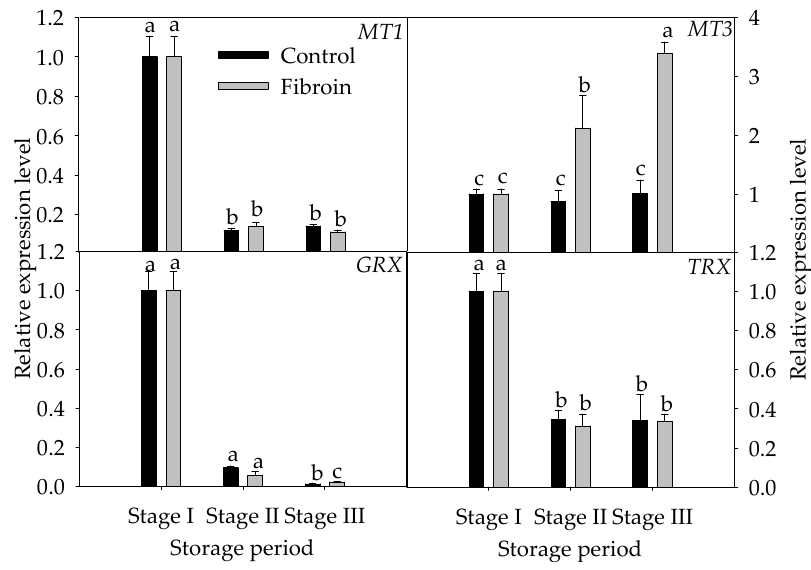
Figure 6. Relative gene expression levels of MT1, MT2, GRX, and TRX in peels of harvested banana fruit during cold storage. The data are presented as means ± standard errors ( n = 3). The means with different letters are significantly different ( p < 0.05).